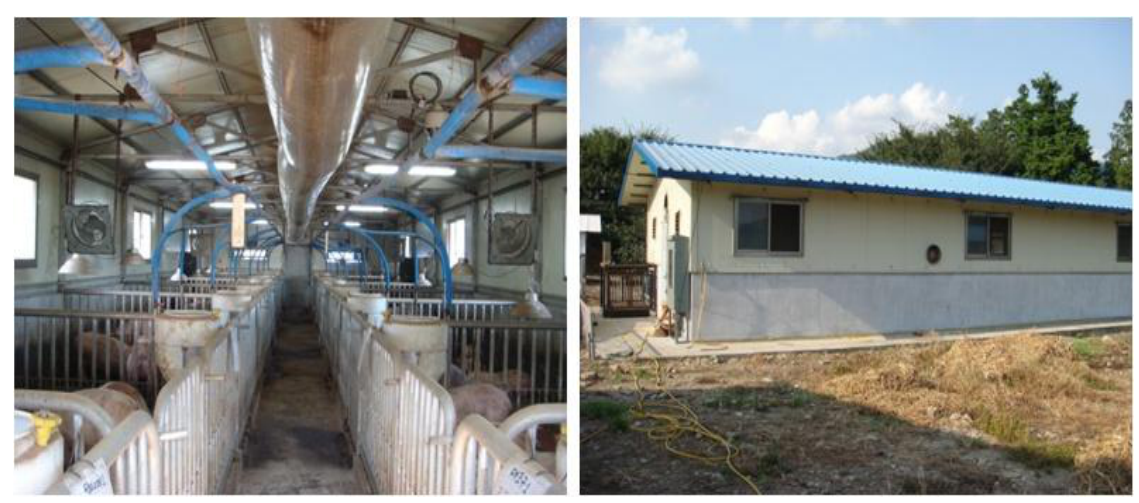
Figure 9. Installation sites of the Ubiquitous Hog Farm